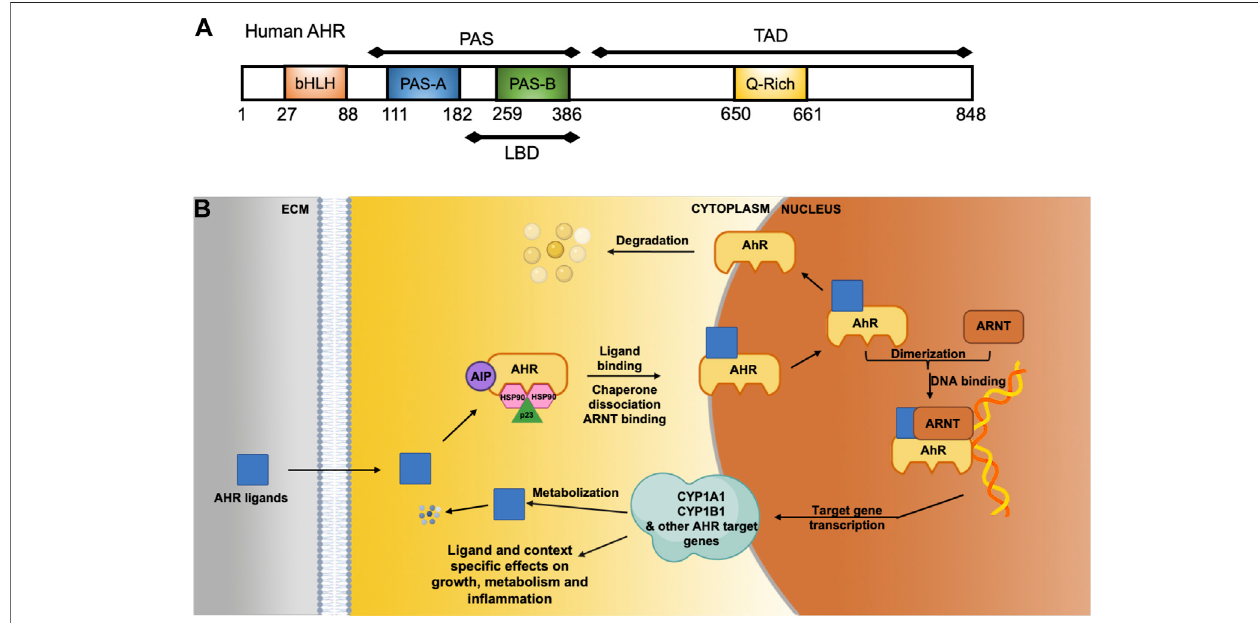
FIGURE 1 | The AHR and its cellular functions as a ligand-activated transcription factor and cytoplasmic modi fi er. (A) Modular diagram of the human AHR protein motifs showing relevant residue numbers (1 – 848). The AHR contains a basic helix-loop-helix (bHLH) DNA binding domain, a Per-Arnt-Sim (PAS) motif, which includes part of the ligand binding domain (LBD) and at the C-terminal region a transcriptional activation domain that includes a glutamine rich Q-rich) motif. (B) Without ligand, AHRislocalizedtothecytoplasmandboundtochaperoneproteinsAIP,HSP90andp23.WhenandAHRligandsentersthecell,theAHRbindstotheAHRnuclear translocator protein (ARNT) in the cytoplasm and is transported into the nucleus where it acts as a transcription factor. AHR-dependent genes include numerous cytochrome P450 enzymes, such as CYP1B1 and CYP1A1, which are involved in metabolism and clearance of xenobiotic polycyclic aromatic hydrocarbons (PAHs).